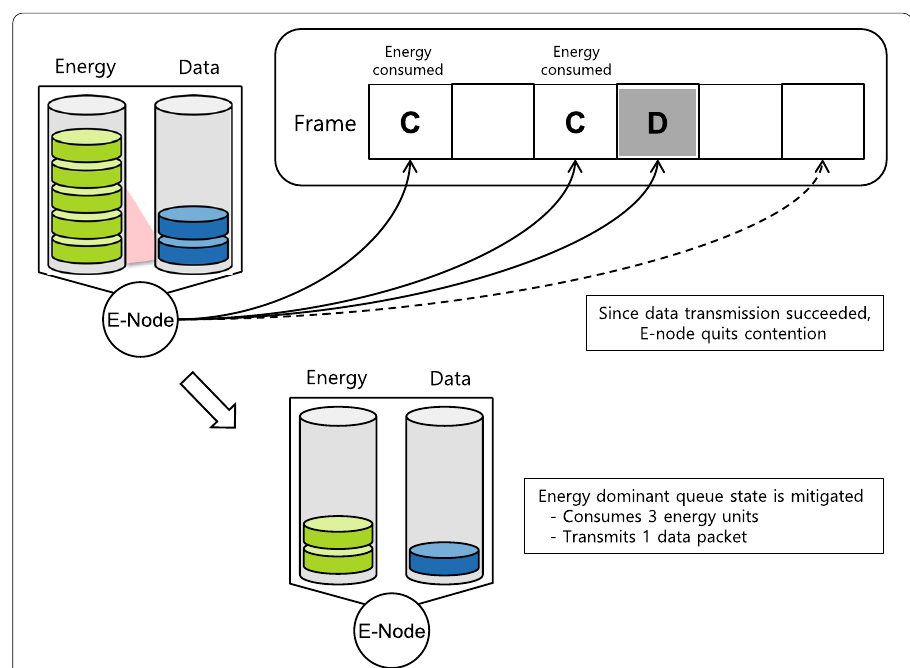
Fig. 1 Multi‑slot operation and the effect of the